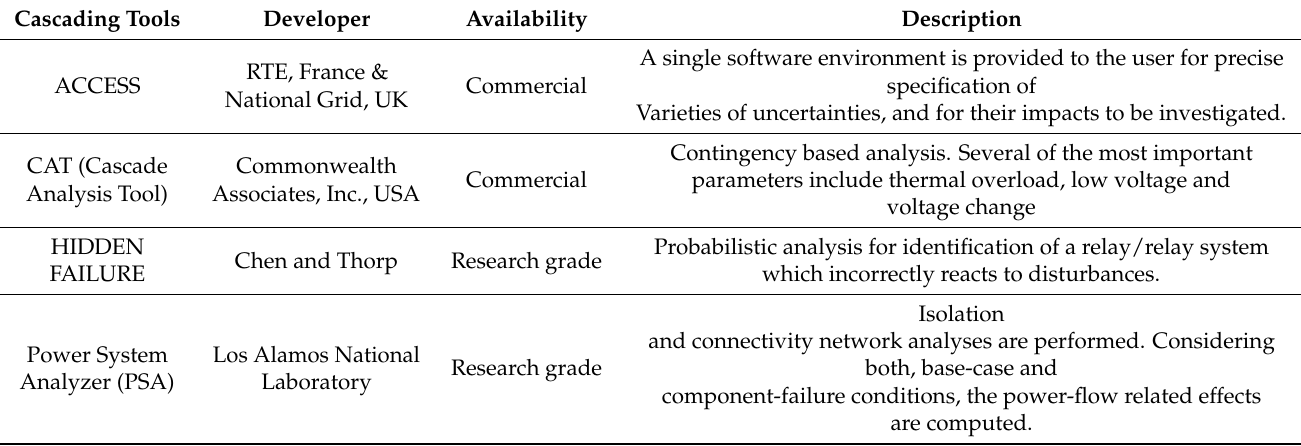
Table 6. Tools for Cascading failure analysis in smart power